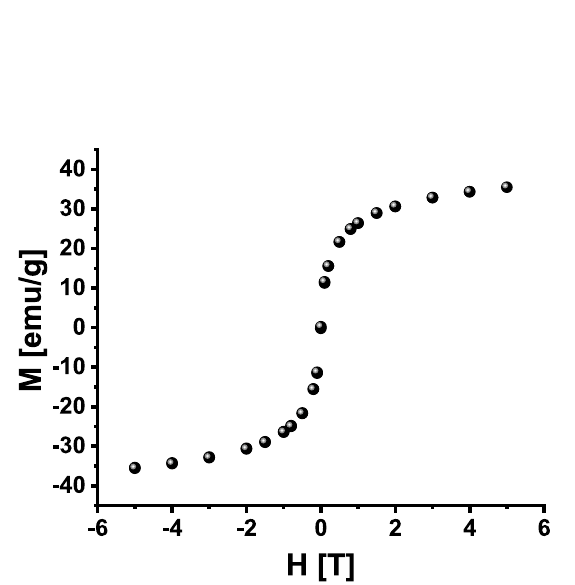
Fig. 10 Magnetization curve of tiron-coated FePt